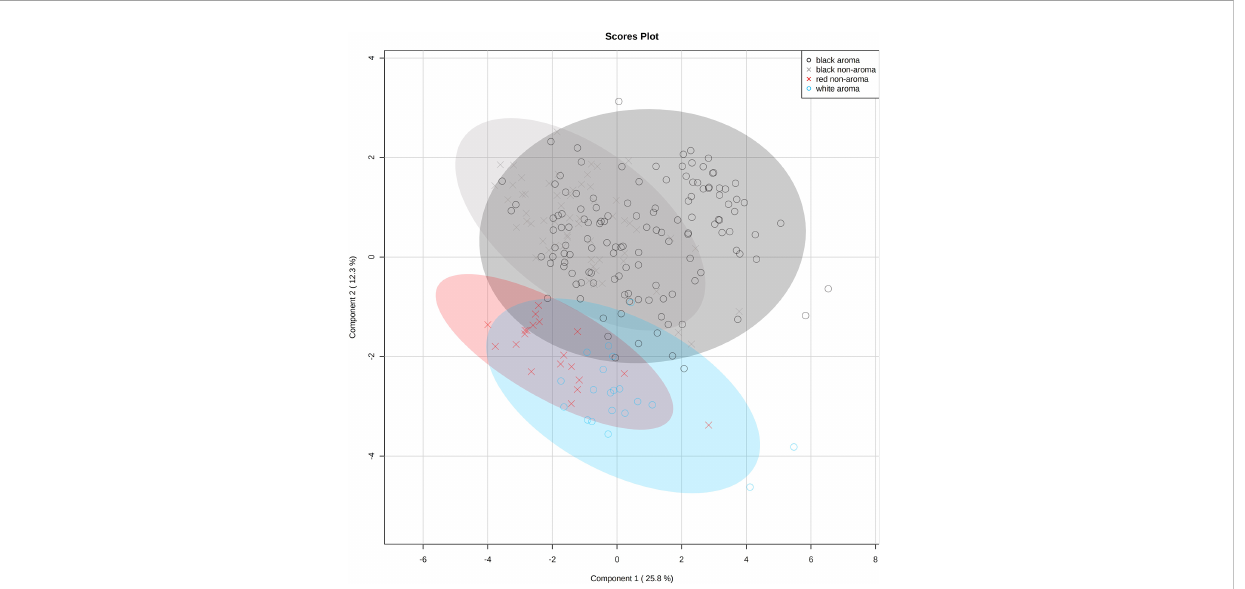
FIGURE 3 Partial least squares-discriminant analysis (PLS-DA) scores plot of volatile pro fi les of 23 Thai rice varieties (aromatic white, aromatic black, non- aromatic black, and non-aromatic red rice samples) identi fi ed by static headspace gas chromatography – mass spectrometry technique. One replication is represented by each symbol (n=10 per rice variety), while 95% con fi dence intervals are represented by shaded